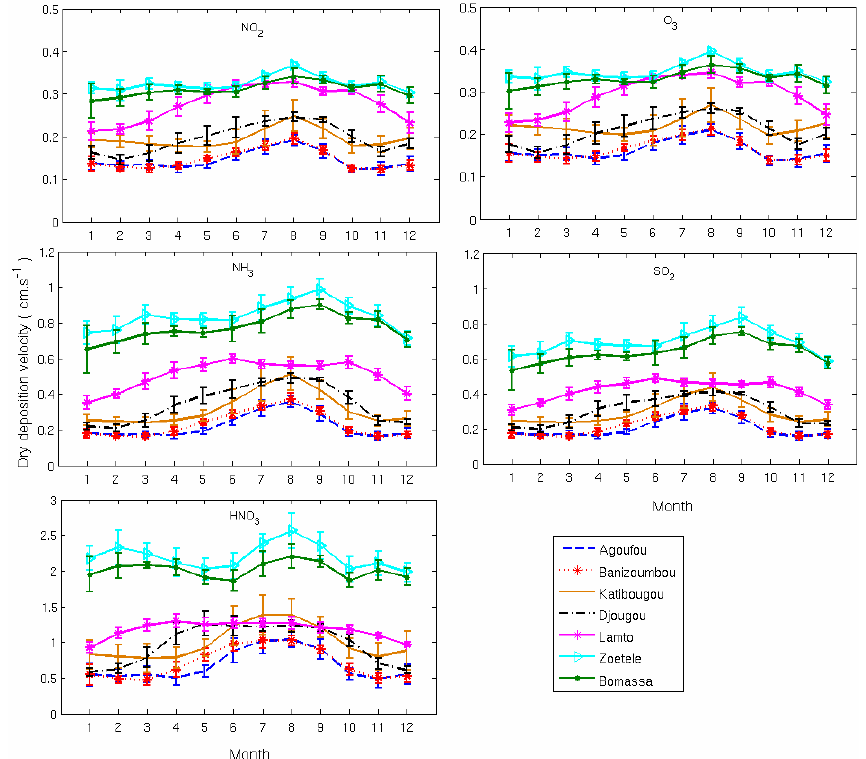
Fig. 4. Monthly variation of dry deposition velocity ( V d ) of NO 2 , NH 3 , HNO 3 , O 3 and SO 2 averaged over the period 2002–2007 for IDAF Fig.4 . Monthly variation of dry deposition velocity (V d ) of NO 2 , NH 3 , HNO 3 , O 3 and SO 2 averaged sites. Vertical bars depict standard deviation over the study over the period 2002-2007 for IDAF sites. Vertical bars depict standard deviation over the study period.